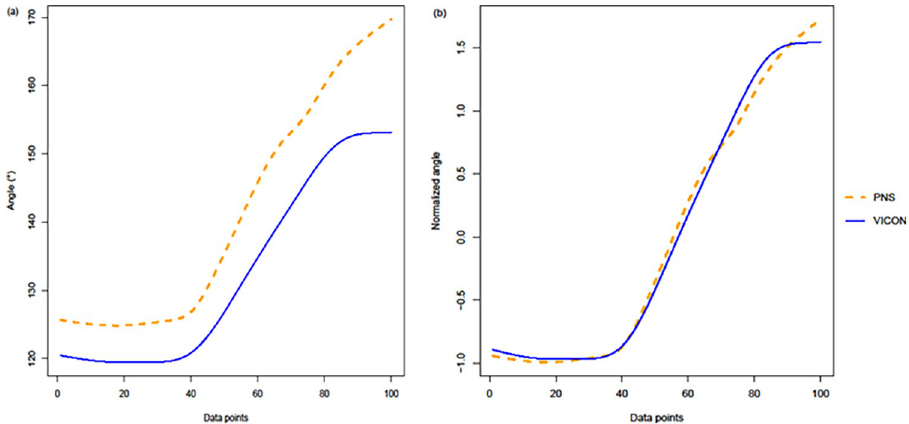
Fig 4. Hip flexion/extension angles during a stationary wrist shot using raw joint angle values (a) and Hip flexion/ extension angles during a stationary wrist shot using normalized joint angle values (b). Data shown is from one trial from one